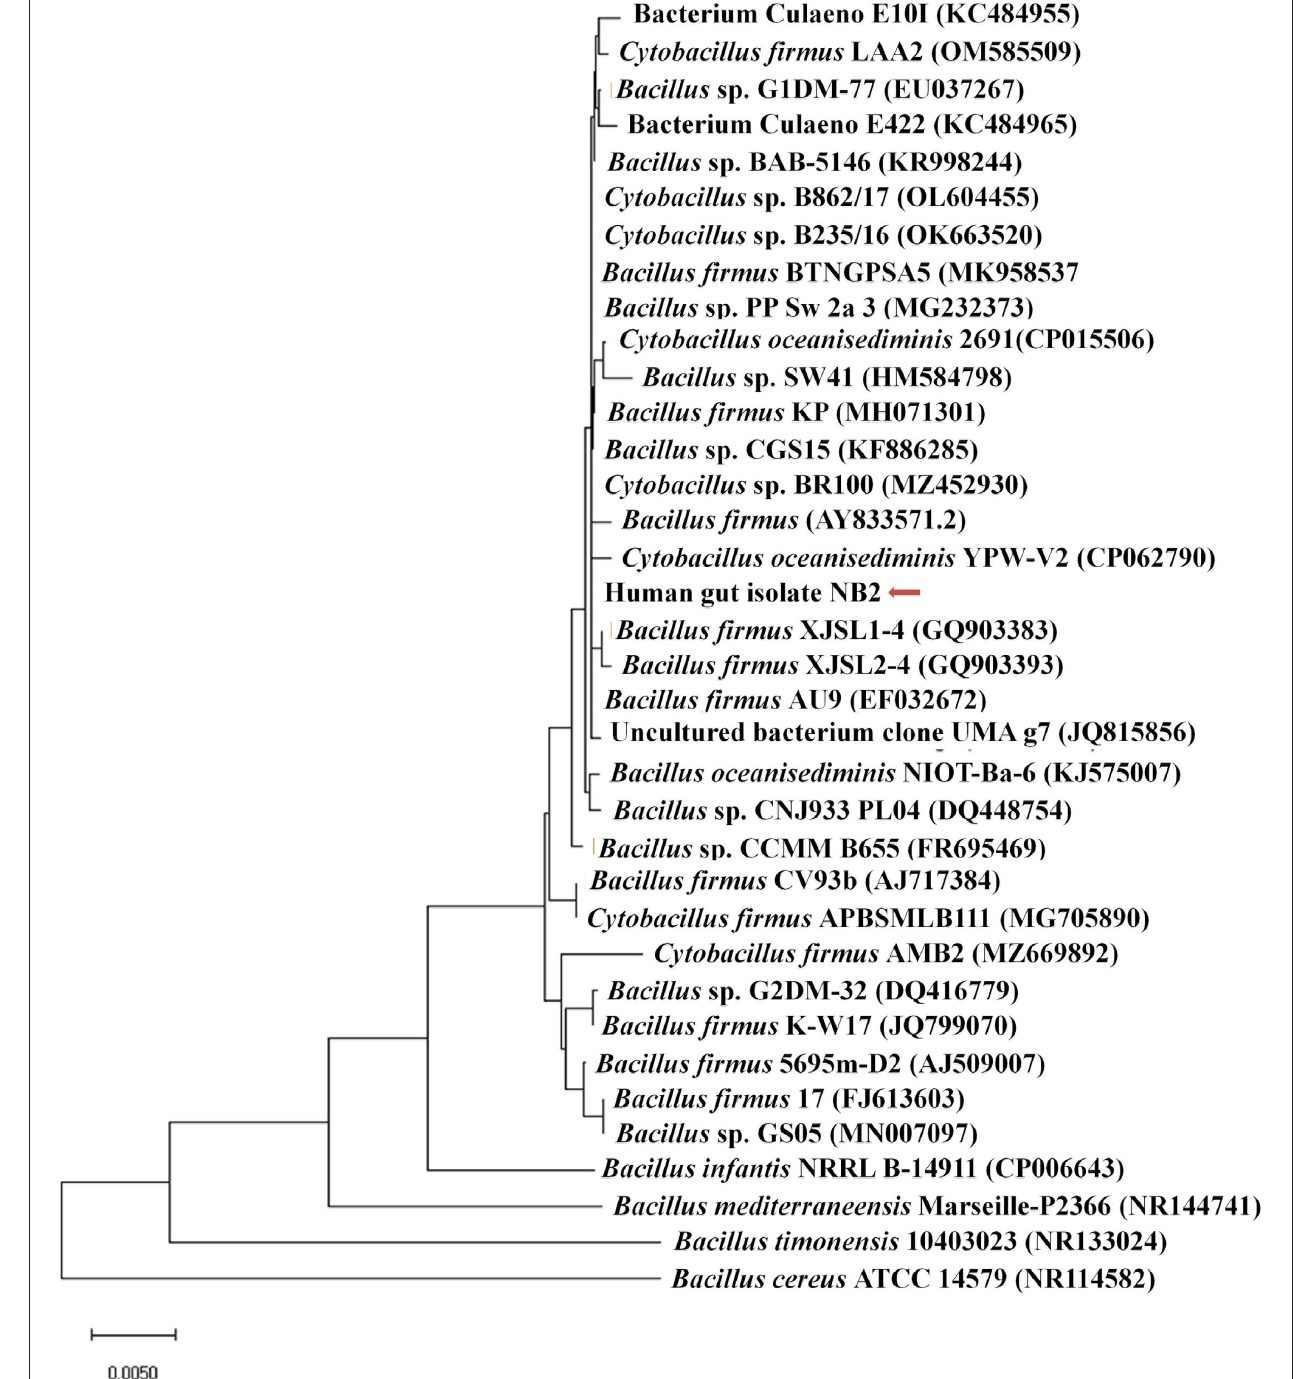
FIGURE 2 | Phylogenetic affiliation of bacterial isolate strain NB2 with the other Bacillus species. Phylogenetic tree was constructed with the neighbor-joining method of phylogenetics using the 16S rRNA gene sequences of bacterial isolate strain NB2 and NCBI database homologs using MEGAX software. Numbers at the node represent bootstrap values in percent for the node (based on 500 bootstrap sampling). Out-group was represented by Bacillus cereus ATCC 14579 SSU rRNA gene sequence.